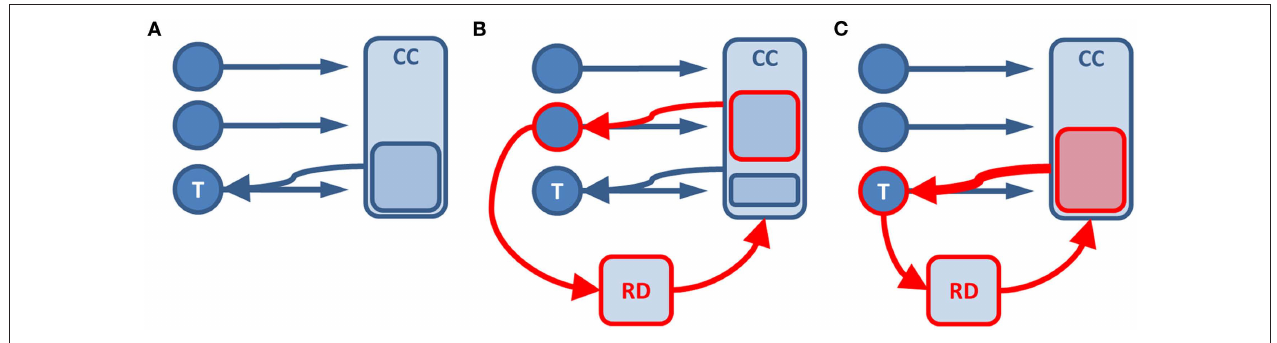
represent stimuli. Rectangles stand for processing units. Red frame color indicates an emotional stimulus or emotion induced processing. T, task-relevant stimulus; CC, cognitive control; RD,